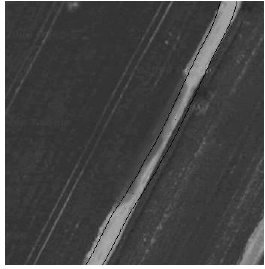
Figure 7: Result of Non-Salient road extraction